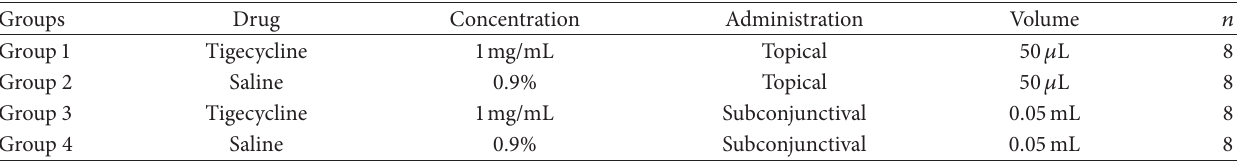
Table 1: Summary of groups